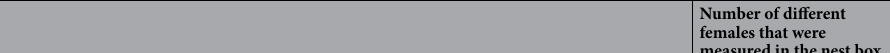
Number of different years in which emergence times were measured in a particular nest box